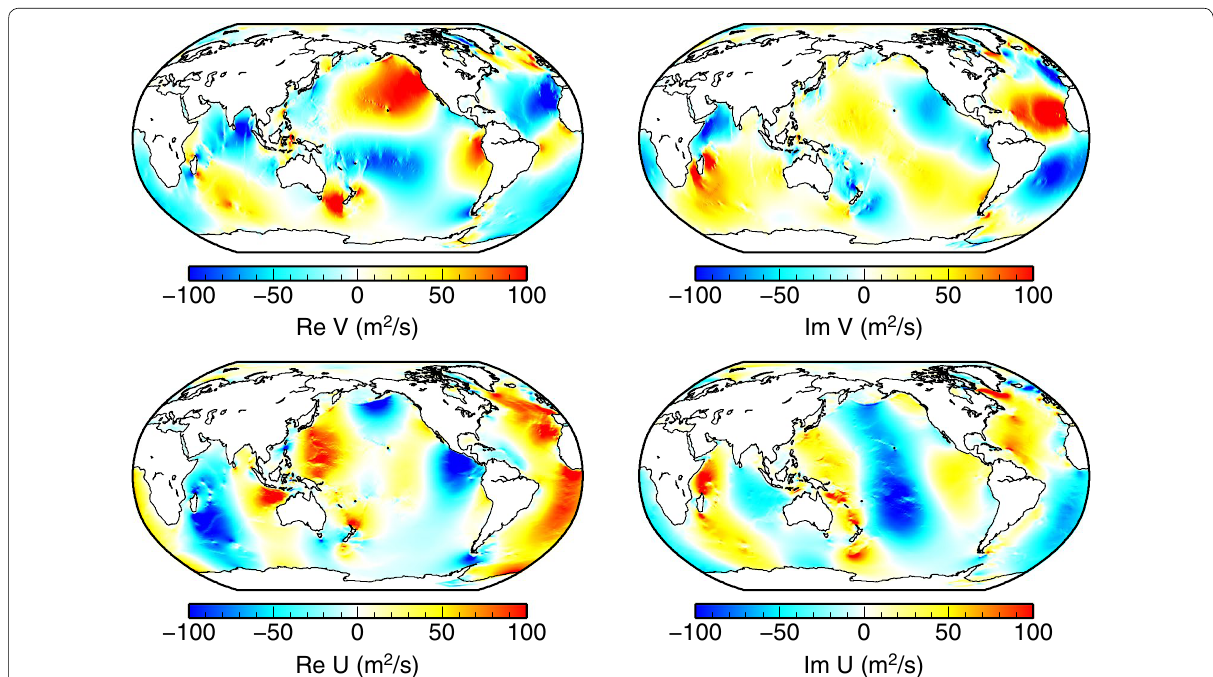
Fig. 1 M 2 transports. The northward component V and the eastward component U of the M 2 transports according to the TPXO8-atlas model (Egbert and Erofeeva